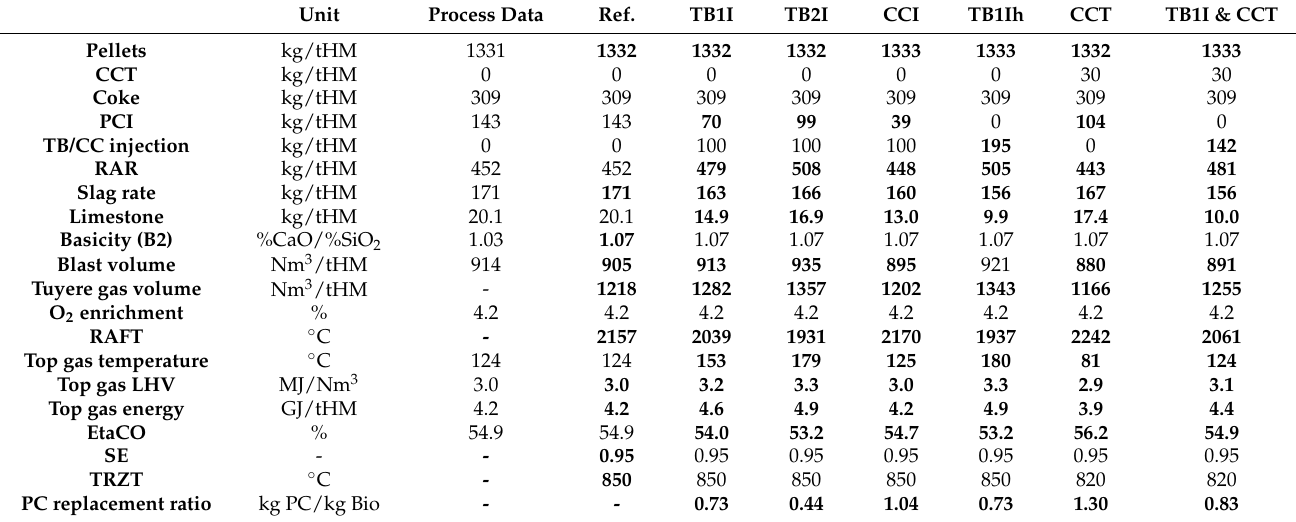
Table 3. Process data, assumed inputs and calculated data, calculated data in